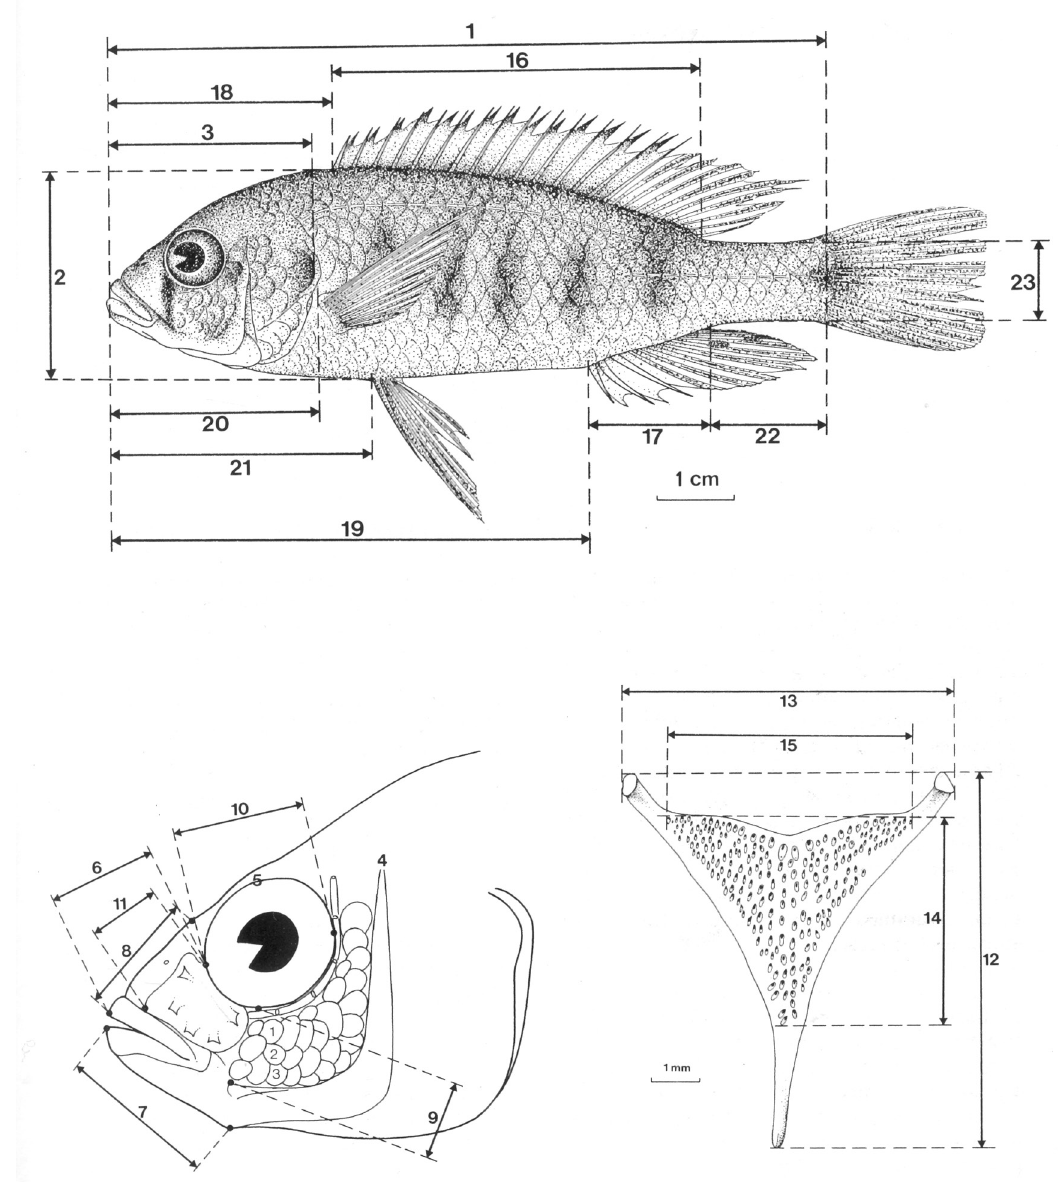
Fig. 1. Morphometric measurements of Astatoreochromis specimens (Snoeks 1994). Body measurements . 1. Standard length (SL). 2. Body depth. 16. Dorsal fin base length. 17. Anal fin base length. 18. Predorsal distance. 19. Preanal distance. 20. Prepectoral distance. 21. Prepelvic distance. 22. Caudal peduncle length. 23. Caudal peduncle depth. Head measurements . 3. Head Length. 4. Head width. 5. Interorbital width. 6. Snout length. 7. Lower jaw length. 8. Premaxillary pedicel length. 9. Cheek depth. 10. Eye diameter. 11. Lachrymal depth. Lower pharyngeal jaw (LPJ) measurements . 12. Lower pharyngeal length. 13. Lower pharyngeal width. 14. Dentigerous area length. 15. Dentigerous area